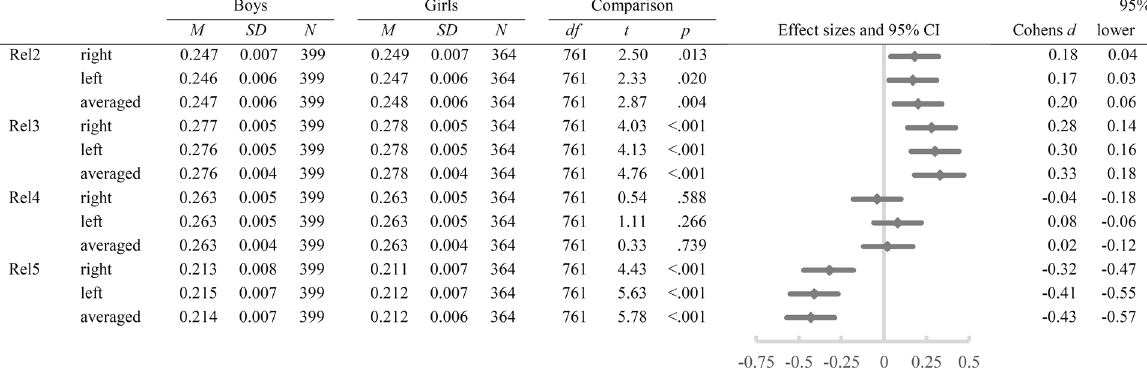
Table 4. Means, standard deviations, post-hoc t -tests, and effect sizes for sex differences in relative digit lengths of both hands (N = 763).